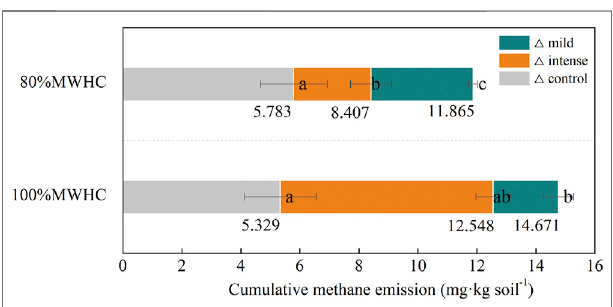
FIGURE 3 | Cumulative methane emission. Mild means freeze – thaw cycle at − 5~4 ° C; intense means freeze – thaw cycle at − 15 – 4 ° C. Triangles ( △ ) indicate the difference of cumulative methane emission between the target setting condition and next sequence setting condition.